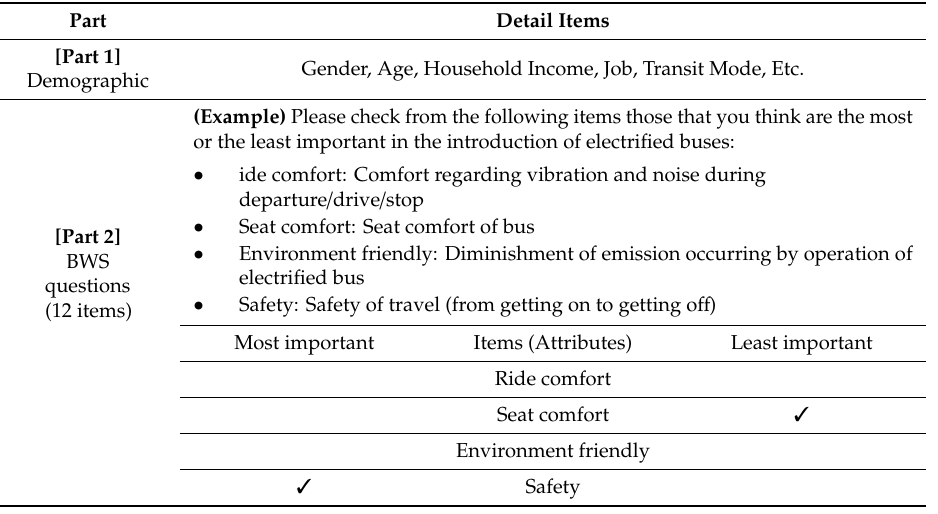
Table 3. Summary of survey questionnaire.